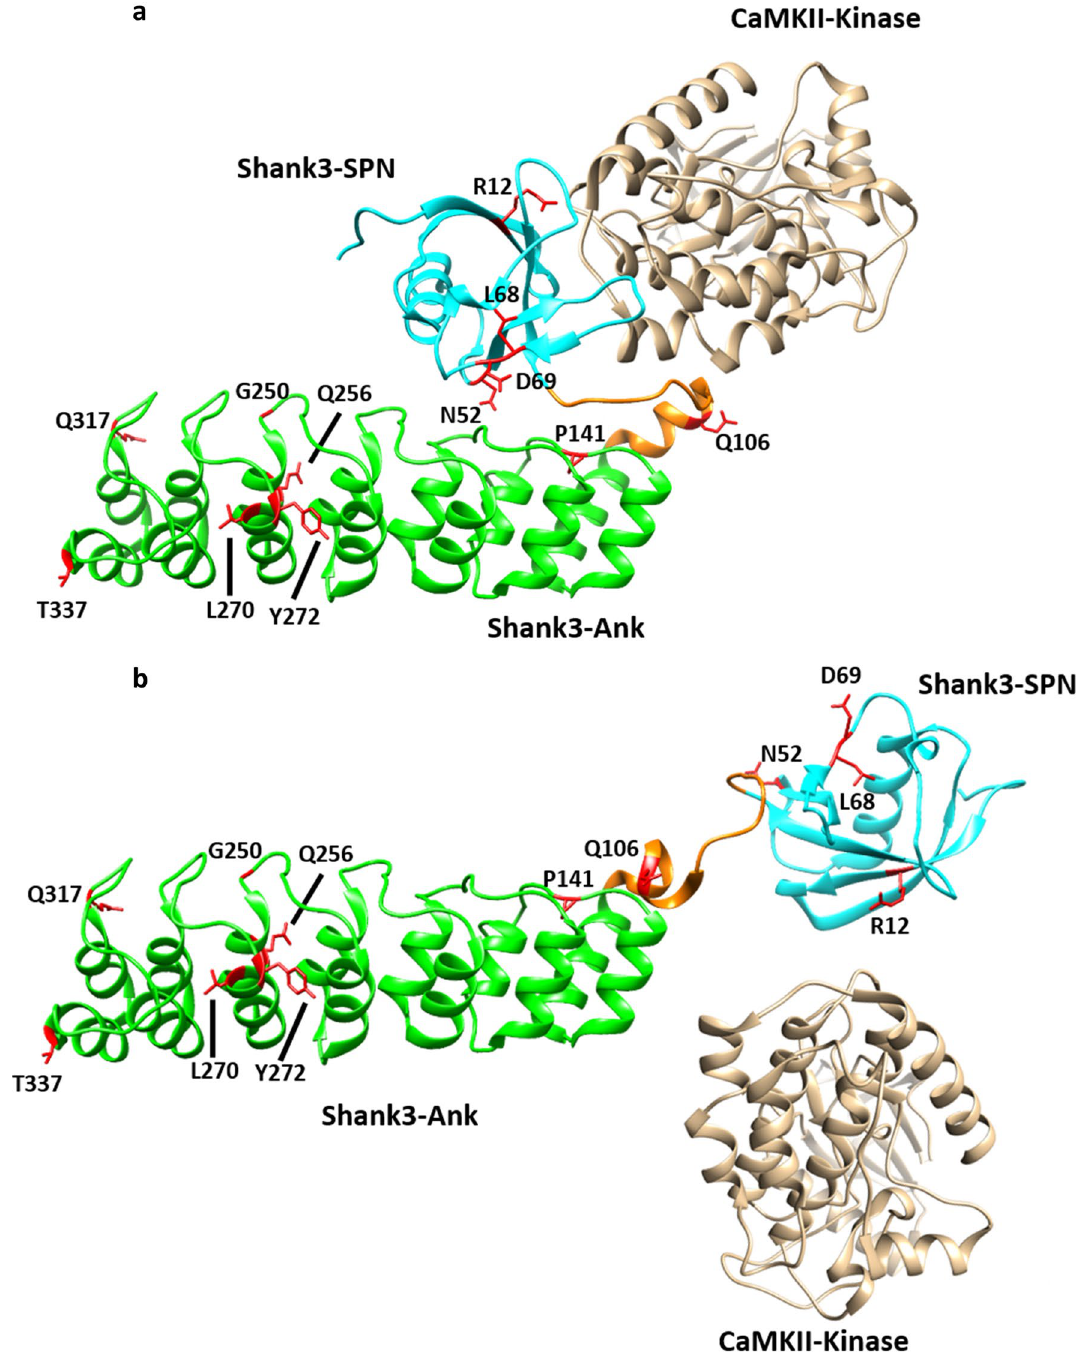
Figure 11. Model of open/closed transition of the N-terminal domains of the Shank3 proteins. ( a ) In the closed conformation, a shallow cavity is formed between the SPN domain, the linker between SPN and Ank, and the N-terminal end of the helix beginning with Q106. Bound αCaMKII covers a large part of this interface through interactions with both the SPN and the linker sequence, including and up to Q106. ( b ) Upon disruption of the SPN − Ank interaction, the geometry of the αCaMKII binding site is altered and αCaMKII cannot bind anymore. Model based on the crystal structure of the Shank3 N-terminus (5G4X) 18 and models of the Shank3/ αCaMKII complex shown in Ref. 24